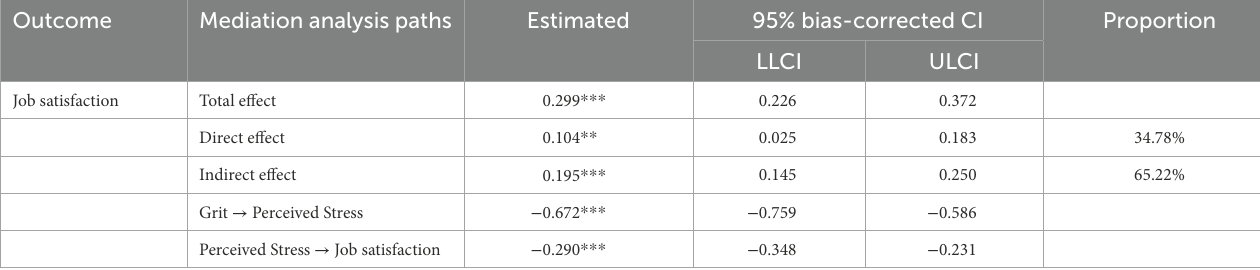
TABLE 3 Mediation effect of perceived stress on the relationship between grit and job satisfaction ( n = 709).